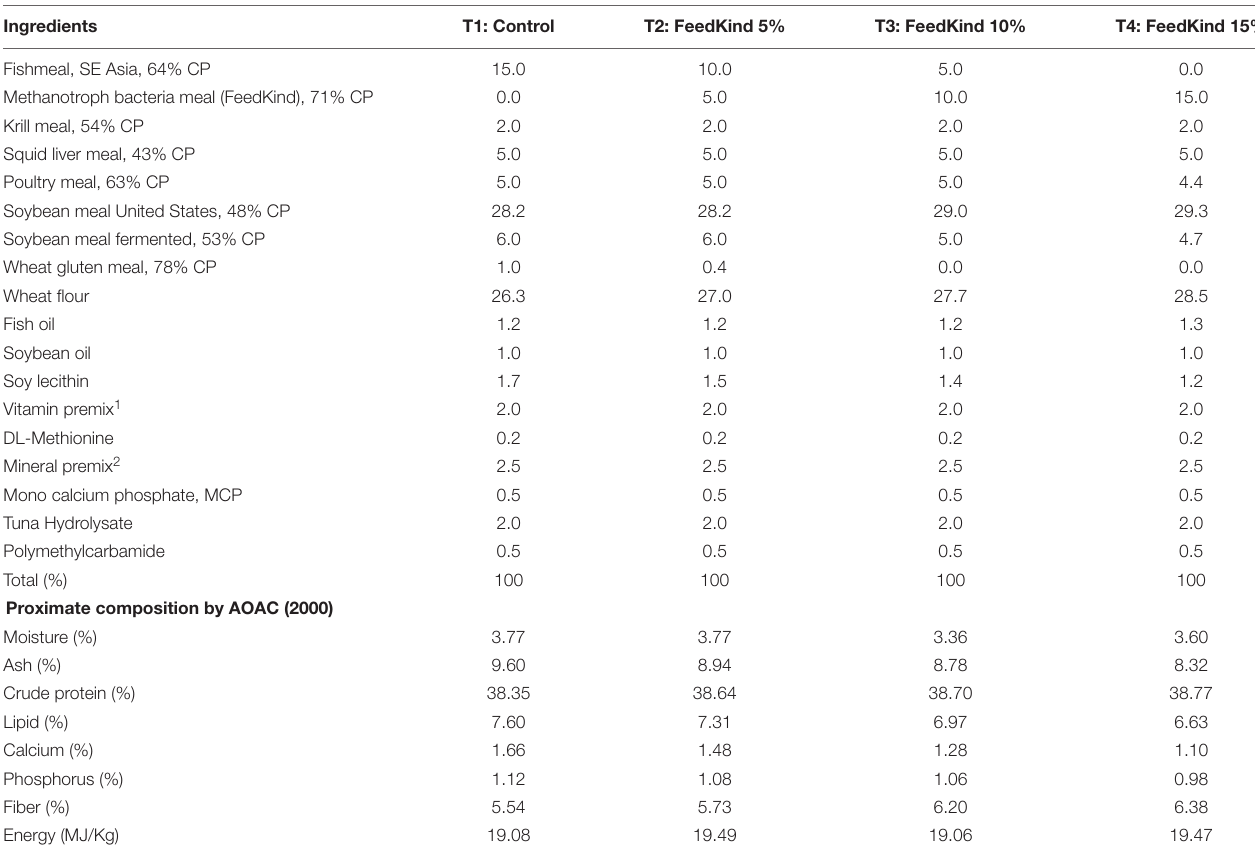
TABLE 1 | Compositions of treatment diets expressed as percentages (where CP = crude